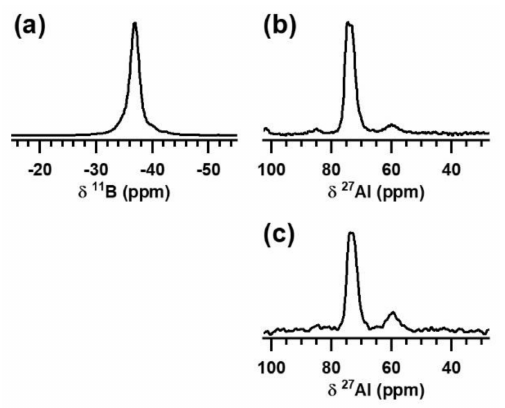
Figure 4. ( a ) 11 B DPMAS, ( b ) 27 Al DPMAS, and ( c ) 27 Al{ 1 H} J –HMQC spectra of the products of the 2LiBH 4 -1AlCl 3 mixture ball-milled for 3 h. The DPMAS spectra (a, b) were acquired with a single pulse excitation, using flip angle of 10 ◦ , ν RF ( 11 B) = 50 kHz, ν RF ( 27 Al) = 50 kHz, 1 H) = 50 kHz for SPINAL-64 decoupling, and τ ν RF ( RD = 0.5 s. The J –HMQC spectrum was obtained using ν RF ( 1 H) = 100 kHz for the FSLG decoupling and short pulses, and 50 kHz for SPINAL-64 decoupling during the acquisition, ν RF ( 27 Al) = 50 kHz and 20 khz for the initial π /2 pulse and the inversion π pulses, respectively, τ max = 2.8 ms, and τ RD = 1.0